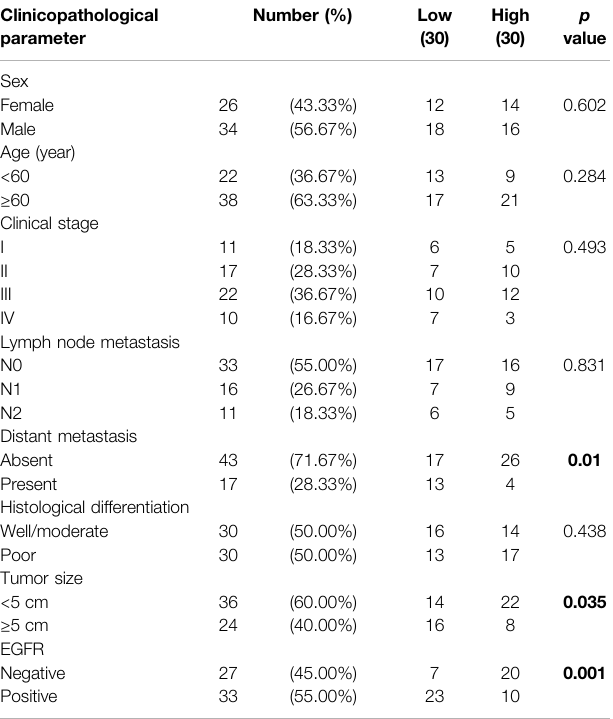
TABLE 1 | Relationship between miR-320d expression and CRC Clinicopathological